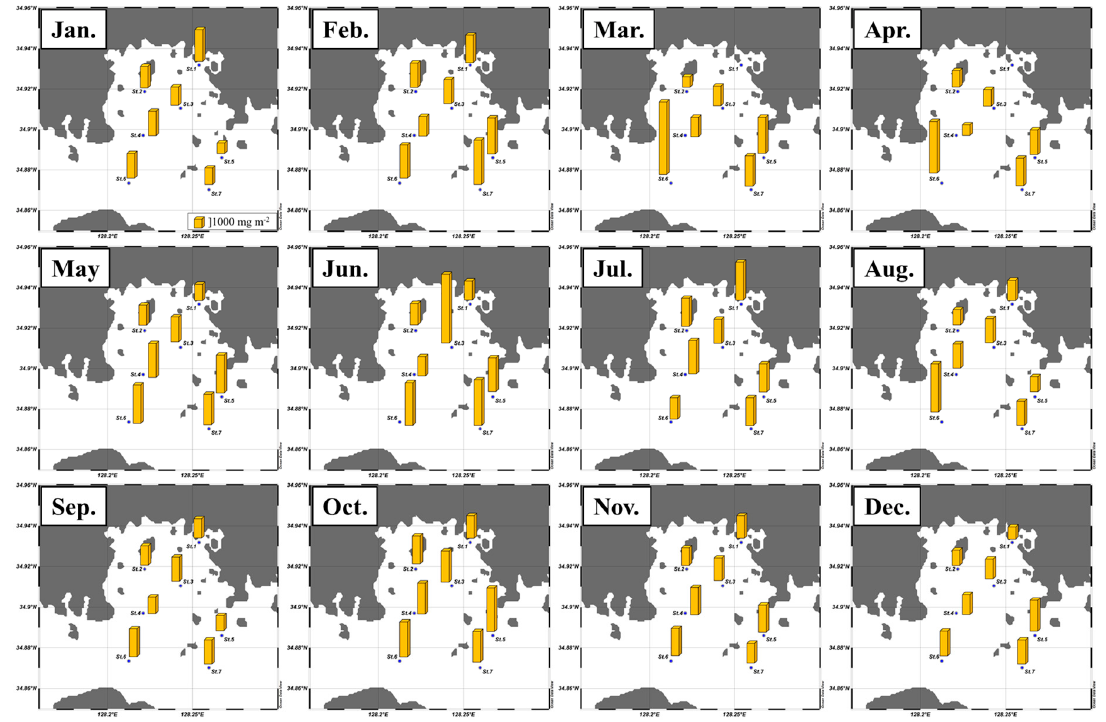
Figure 6. Water column-integrated the total FM concentrations at the sampling stations in Jaran Bay.